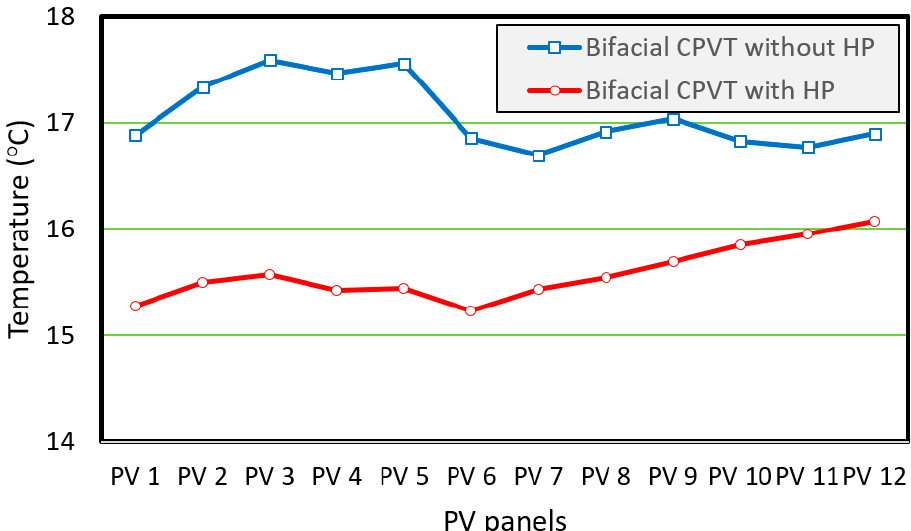
Figure 7. Temperature of each PV panel for the bifacial CPVT systems with and without HP.